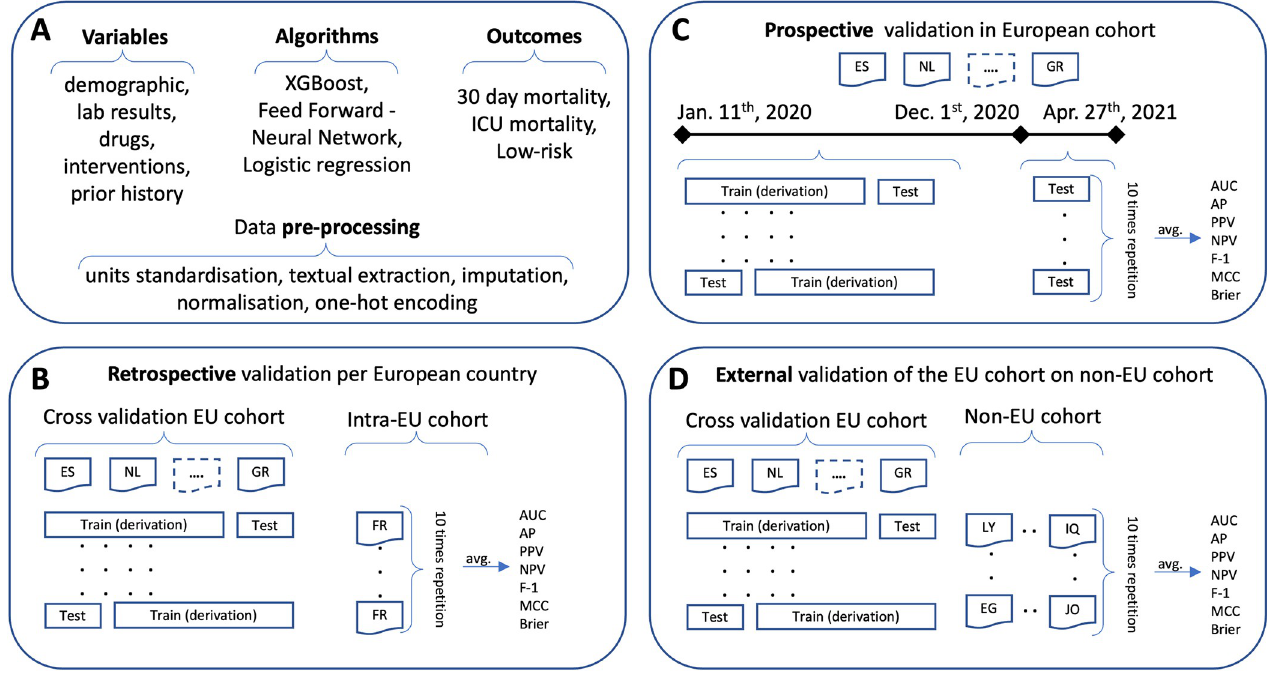
Fig 1. Description of variables, algorithms, and outcomes as well as pre-processing steps for the overall dataset (panel A). Retrospective validation of the model derived on the European cohort based on cross-validation as well as external validation on France as the country with highest ICU admissions (panel B), while the results for the rest of the European countries are shown in Tables A-C in S6 Text. Prospective validation of the model derived on the European cohort of patients admitted to ICUs before the cut-off date (December 1st, 2020) and validated on the European cohort of patients admitted to ICUs after the cut-off date, during the subsequent pandemic wave (panel C). External validation of the model derived on the overall European cohort and validated on the cohort of patients admitted to Asian, African and American ICUs (panel D). Note, EU is an abbreviation of Europe.